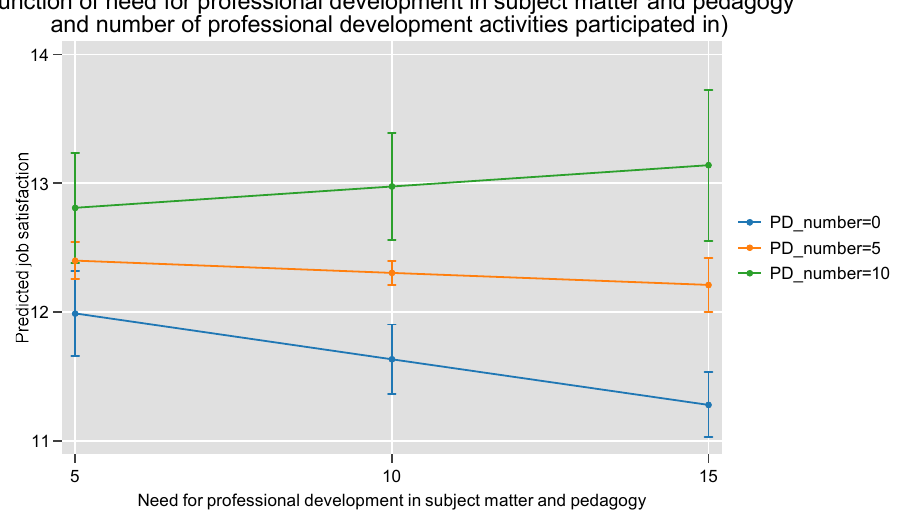
Figure 2. Predicted job satisfaction as a function of the need for professional development in subject matter and pedagogy and the number of professional development activities participated in.